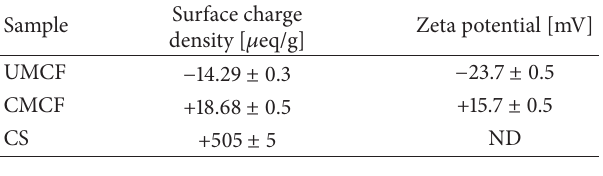
Table 2: The analysis of surface charge density and zeta potential.